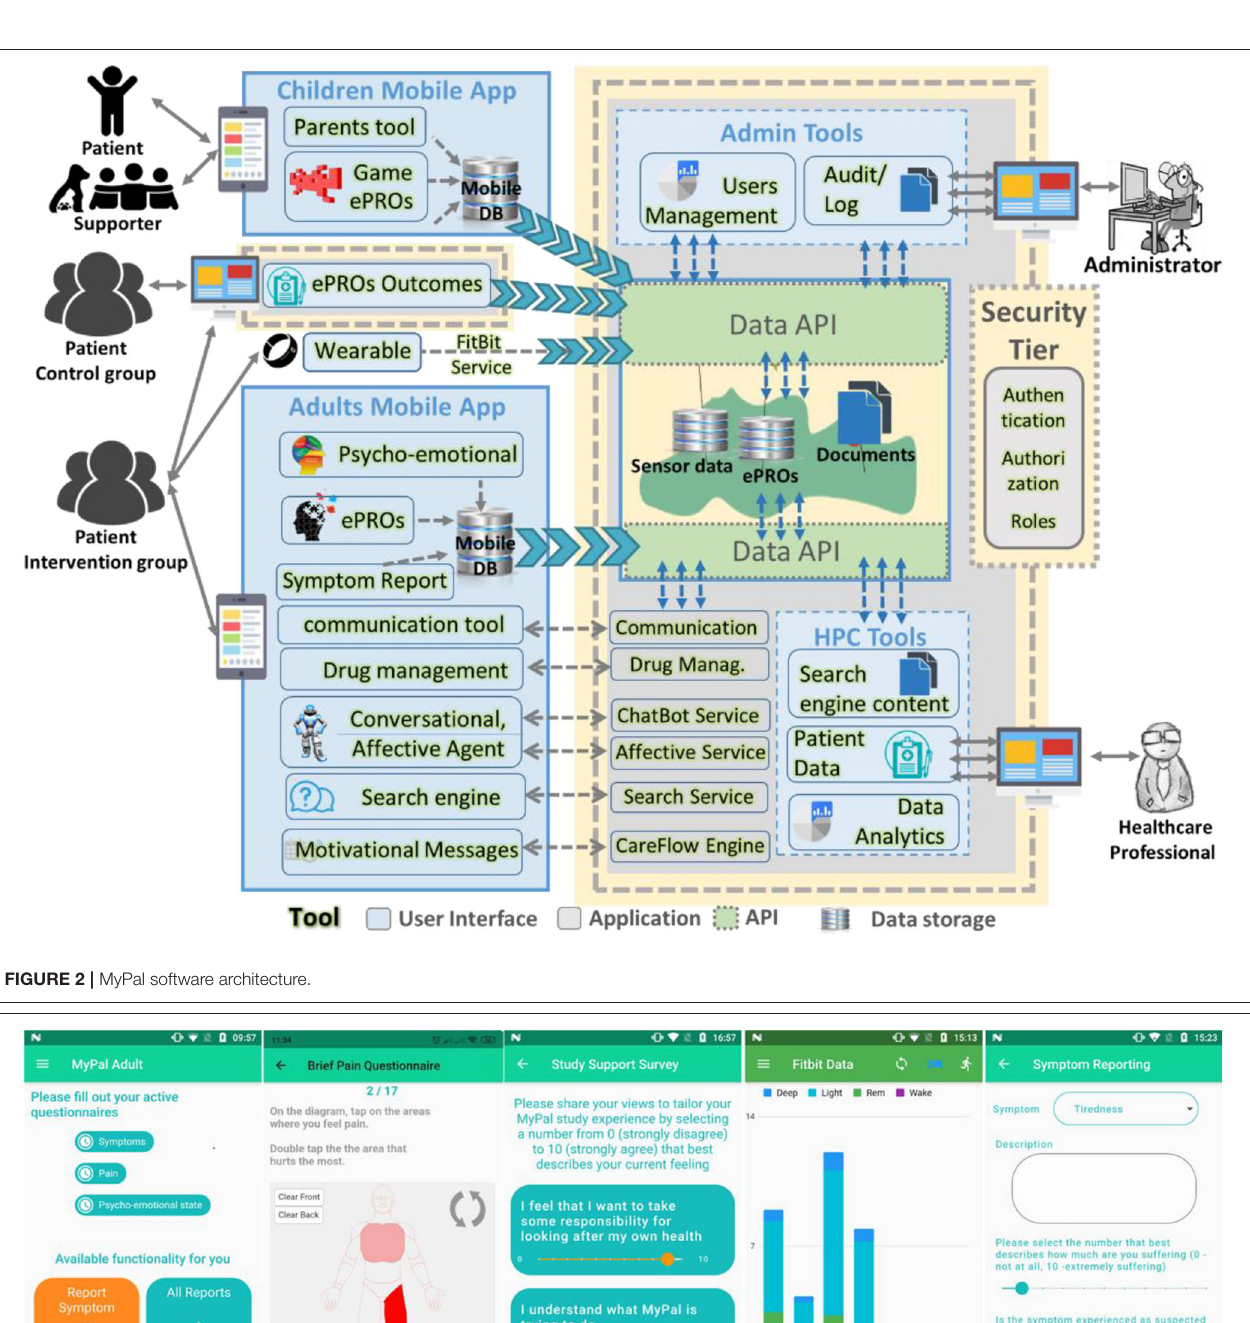
FIGURE 3 | MyPal Mobile application screenshots. From left to right: (i) MyPal main menu, (ii) brief pain questionnaire, (iii) survey, (iv) activity data, (v) symptom reporting.